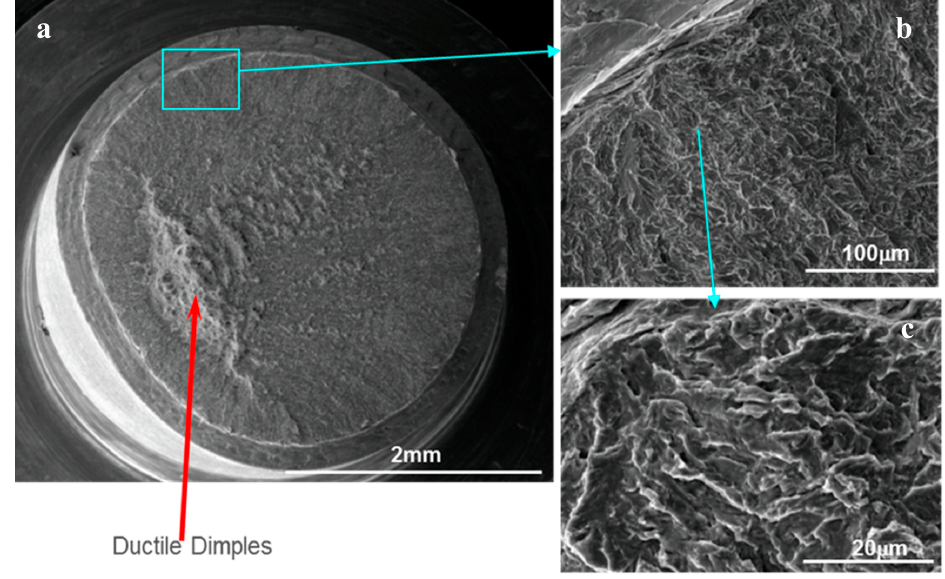
Figure 6. ( a ) Fracture surface of the notched specimen (B87) tested in liquid lead at 350 °C, R1 (2 × 10 − 6 m/s); a small area of ductile fracture stayed in the central area, ( b ) selected detail of crack-initiation site showing ( c ) characteristic cleavage-like patterns.